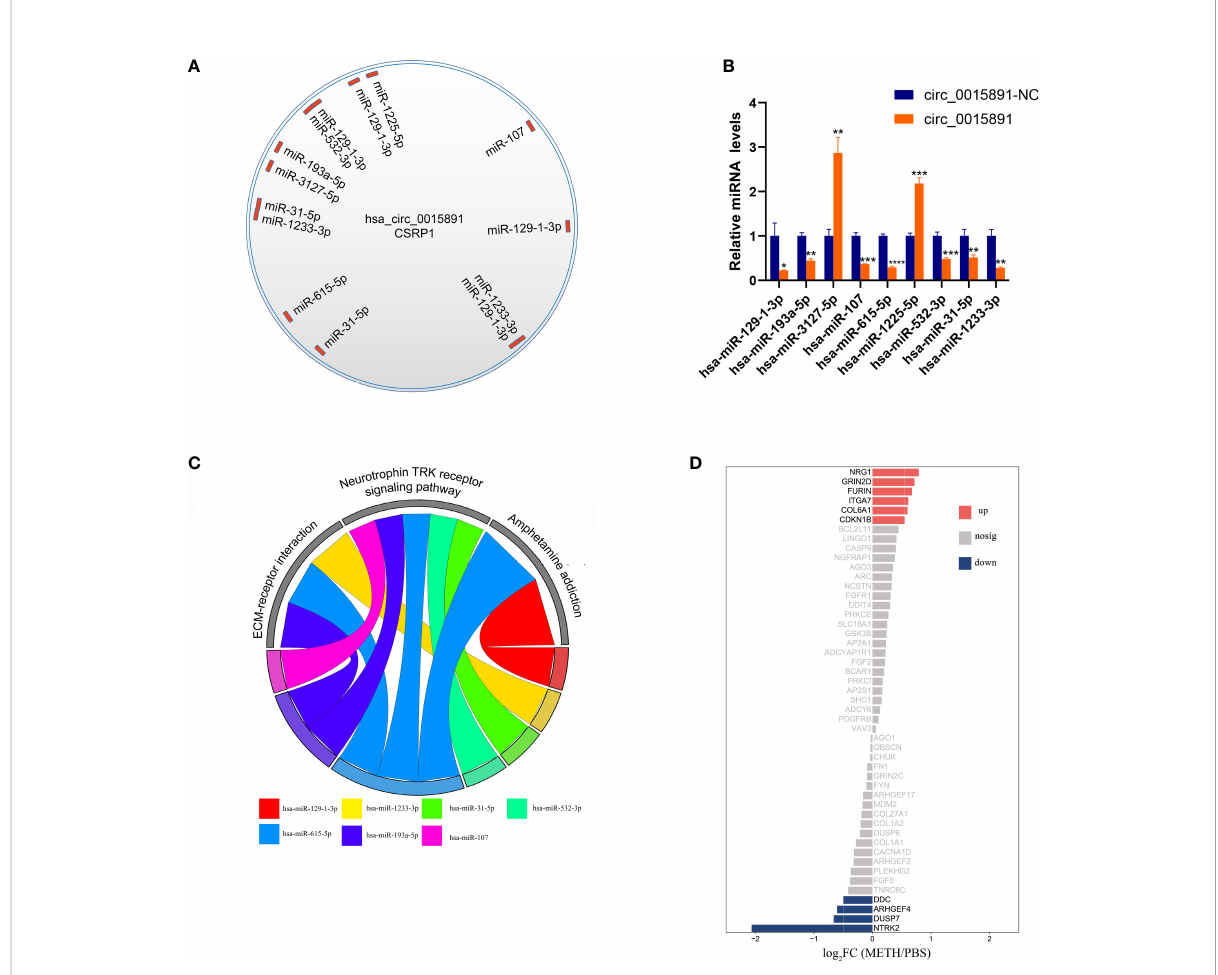
FIGURE 6 Bioinformatic analysis of circ_0015891 sponged miRNAs. (A) The predicted miRNAs that could bind with circ_0015891. (B) Relative levels of predicted miRNAs with or without circ_0015891-treatment detected by RT-qPCR assay. (C) String diagram of eligible miRNAs and pathways. Each color represents a miRNA. The string connecting the pathway and the miRNA represents the involvement of the miRNA in the pathway. (D) Bi-directional bar graph of proteins. *P < 0.05; **P < 0.01; ***P < 0.001; ****P <